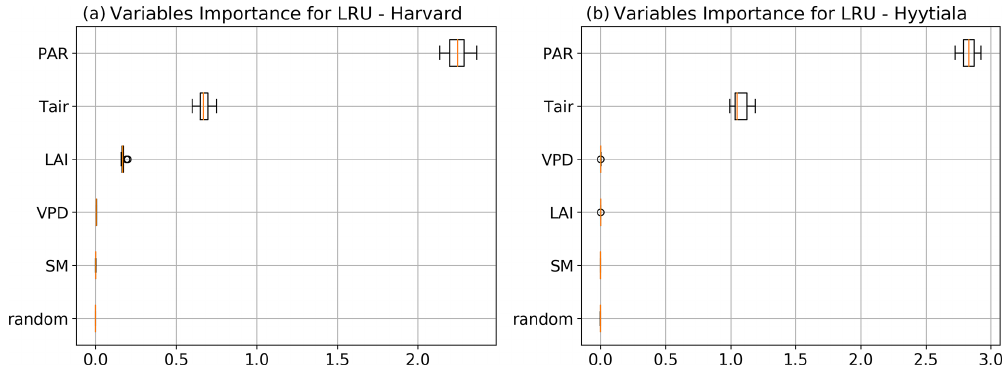
Figure B6. Same as B3 for the leaf relative uptake